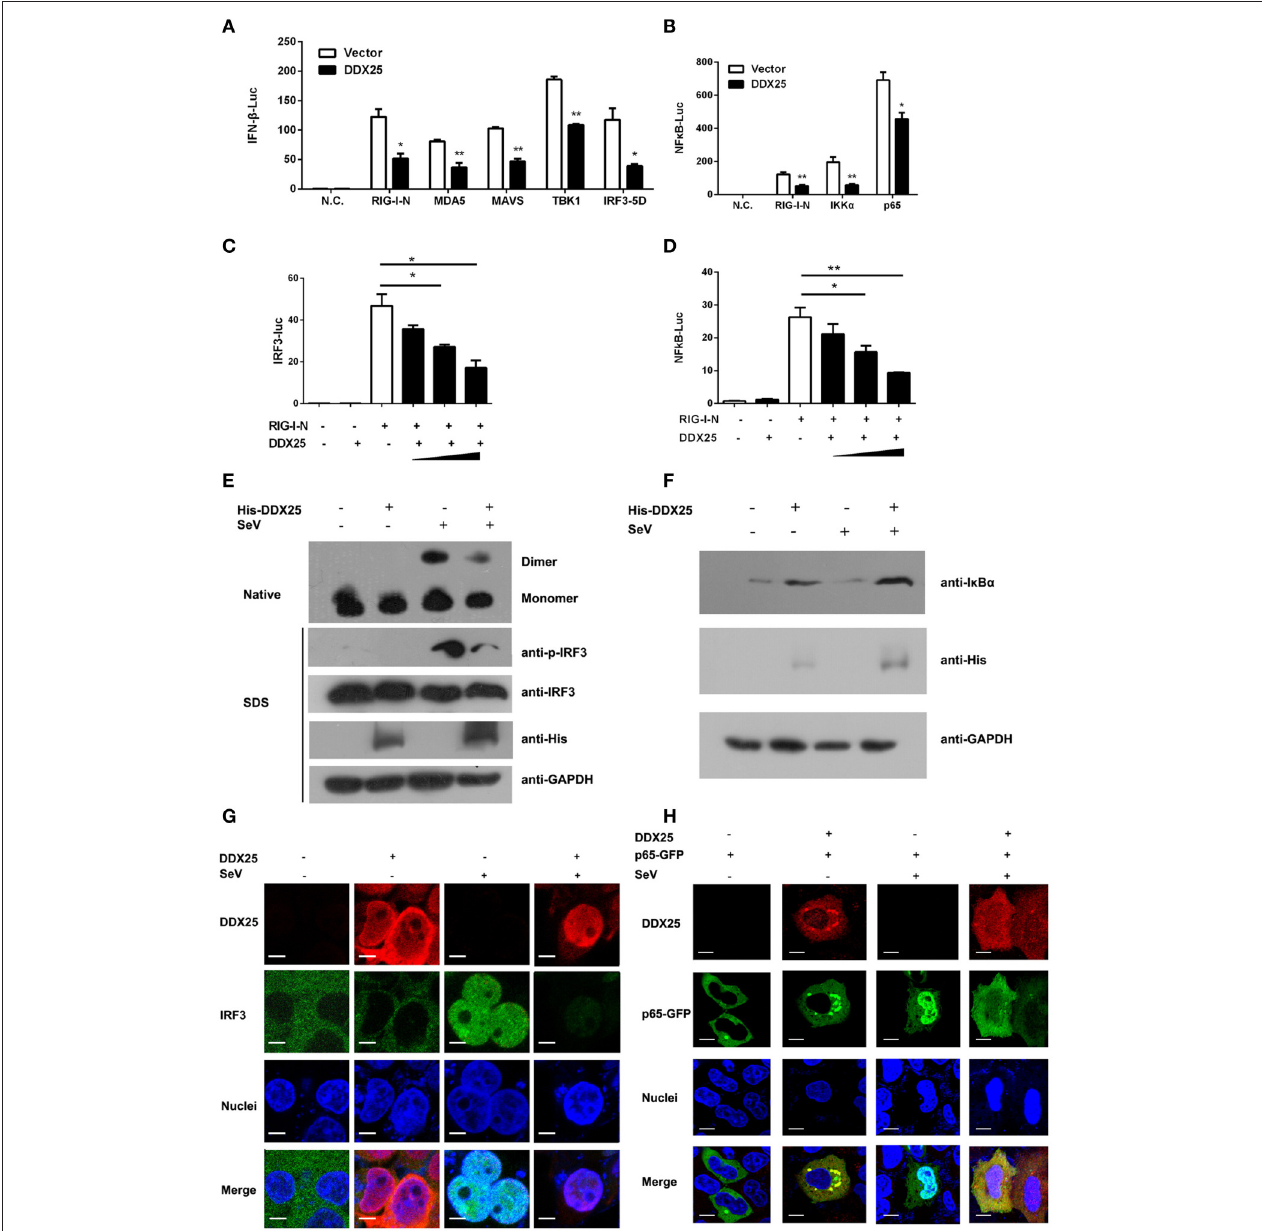
FIGURE 5 | DDX25 interrupts the IFN-signaling pathway by blocking IRF3 and NF κ B activation. (A) Overexpression of DDX25 inhibits RIG-IN, MDA-5, MAVS, TBK1, and IRF3-5D directed IFN β promoter activation. IFN β -Luc assay was performed in vector or DDX25 transfected HEK293T cells. IFN β promoter activations were driven by co-expression of distinct RIG-I signaling pathway molecules. (B) Overexpression of DDX25 inhibits IG-IN, IKK α , and NF κ B p65 induced NF κ B promoter activation. NF κ B promoter was activated by transfecting RIG-IN, IKK α , or NF κ B p65, and measured by a NF κ B-Luc. (C,D) DDX25 suppresses RIG-IN directed IRF3-Luc (C) and NF κ B-Luc (D) in a dose dependent manner. Results are expressed as the mean + the SEM. * p < 0.05 and ** p < 0.01 ( t -test). Representative results from at least three independent experiments. (E) Overexpression of DDX25 impaired SeV induced IRF3 phosphorylation and dimerization. (F) Overexpression of DDX25 suppressed SeV induced I κ B degradation. (G,H) Nucleic translocation of IRF3 (G) and NF κ B p65 (H) in SeV stimulated HEK293T cells were impaired by DDX25. Immunofluorescence assay were performed in control or DDX25 overexpressed HEK293T cells with or without SeV infection. IRF3, DDX25 were probed with specific primary antibodies followed by TRITC or FITC labeled secondary antibodies. NF κ B p65 was visualized by a fused GFP protein. Scale bars, 10 µ m.